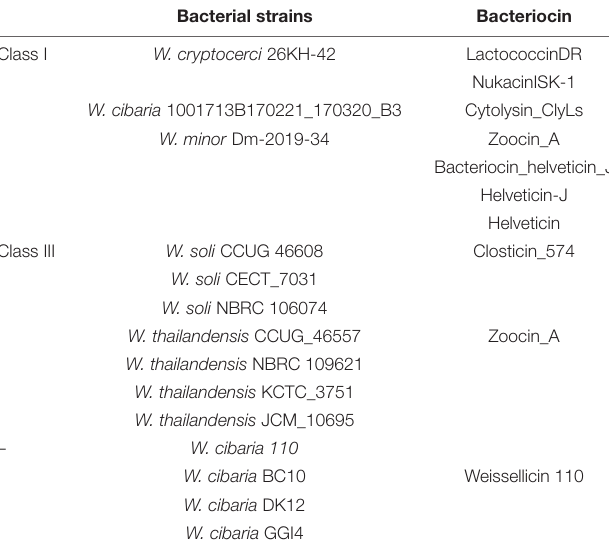
TABLE 3 | NCBI taxonomy status and AAI values. TABLE 4 | Bacteriocin-encoding genes identified in Weissella